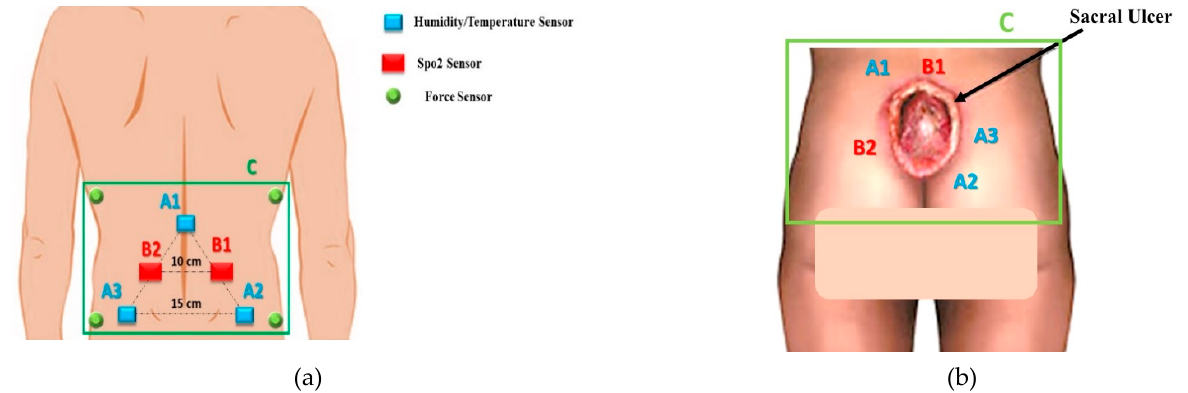
Figure 8. ( a ) Locations of the sensors covering the targeted area in control subjects. ( b ) Locations of sensors around the sacral ulcer in subjects with PU.